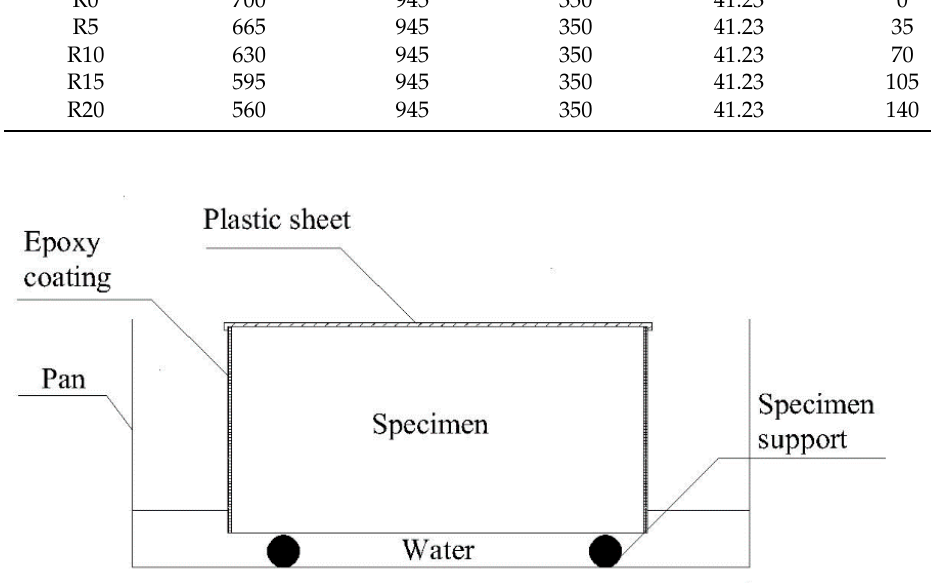
Figure 6. Schematic of the capillary absorption test [40].